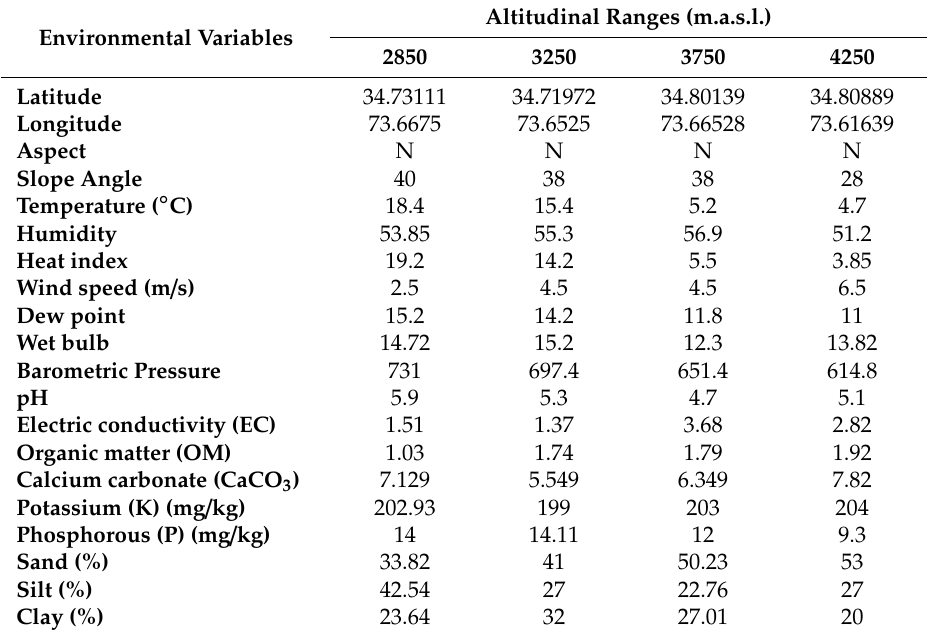
Table 4. Means of environmental variables measured at four di ff erent altitudinal ranges (wind speed averages are given as